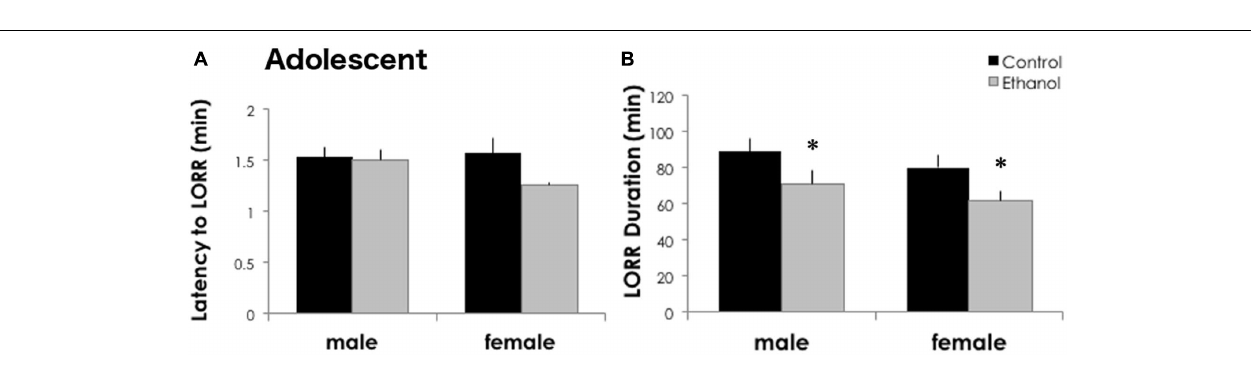
FIGURE 2 | Adolescent ethanol reduces ethanol sensitivity in adolescent DBA/2J mice. (A) DBA/2J males ( n = 9/group) and females ( n = 6–7/group) take a similar amount of time to lose their righting reflex after high doses of ethanol. (B) Both binge treated males and females showed a shorter LORR duration after a high dose of ethanol at PND 46. Data is presented as mean +/– SEM. ∗ p < 0.05, main effect of treatment by Two-Way